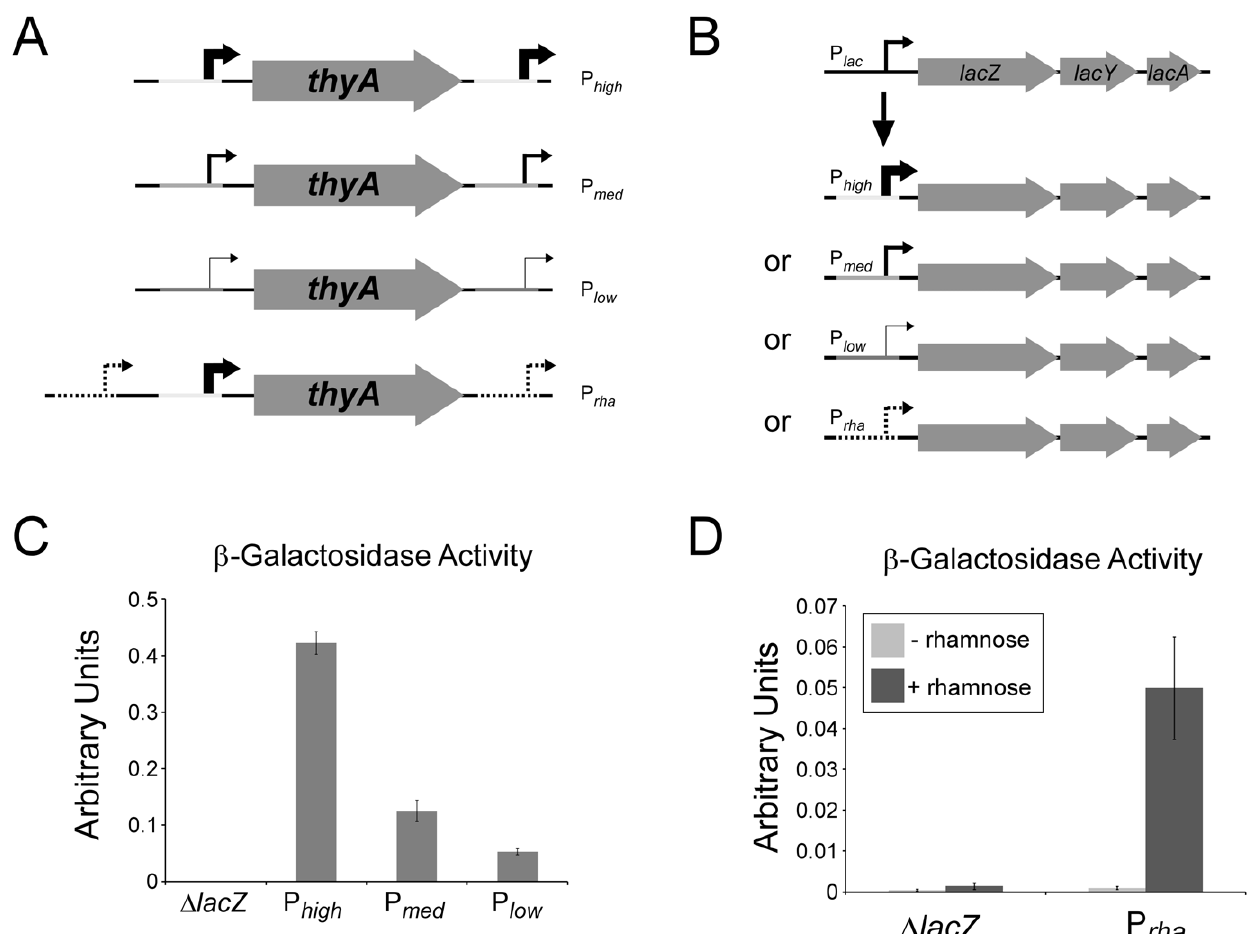
Figure 4. FRUIT promoter swaps in MG1655 ( E.coli K-12). (A) Schematic indicating the plasmid templates used for FRUIT. (B) Schematic indicating replacement of the lacZYA promoter with P high , P med , P low or P rha promoters. (C) b -galactosidase assay in D lacZ MG1655 and mutant strains with P high , P med or P low driving expression of lacZYA (cells were grown without IPTG). (D) b -galactosidase assay in D lacZ MG1655 and a mutant strain with P rha driving expression of lacZYA . Assays were performed 6 rhamnose.